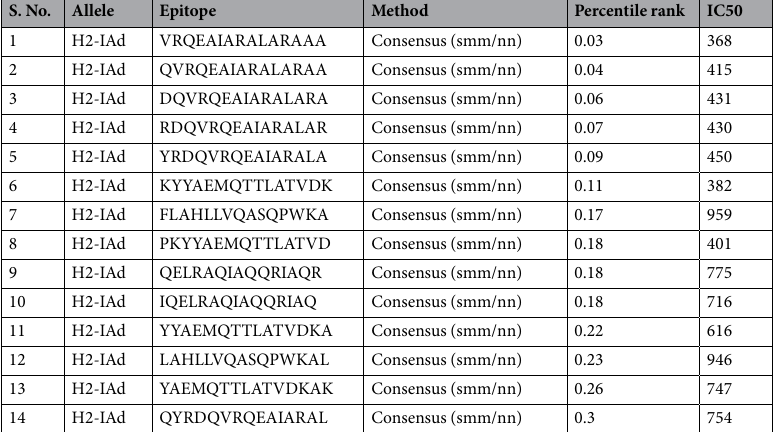
Table 2. Predicted Helper T-lymphocyte (HTL) specific epitopes and their percentile rank obtained from the immune epitope